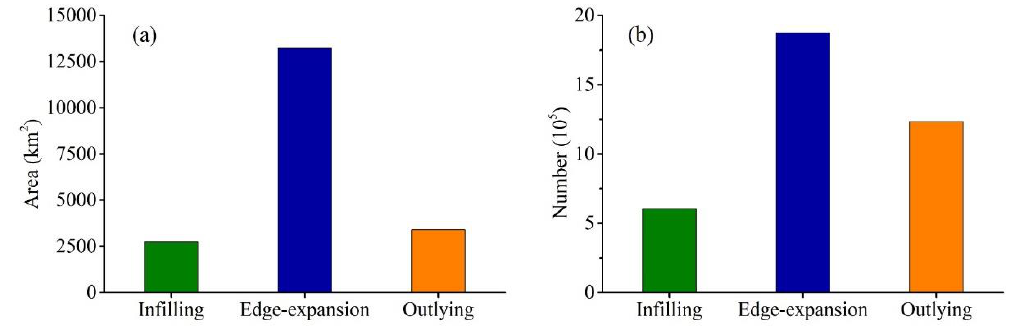
Figure 9. Patch number ( a ) and area ( b ) of three BLF expansion types in the study area in 1975–2014.